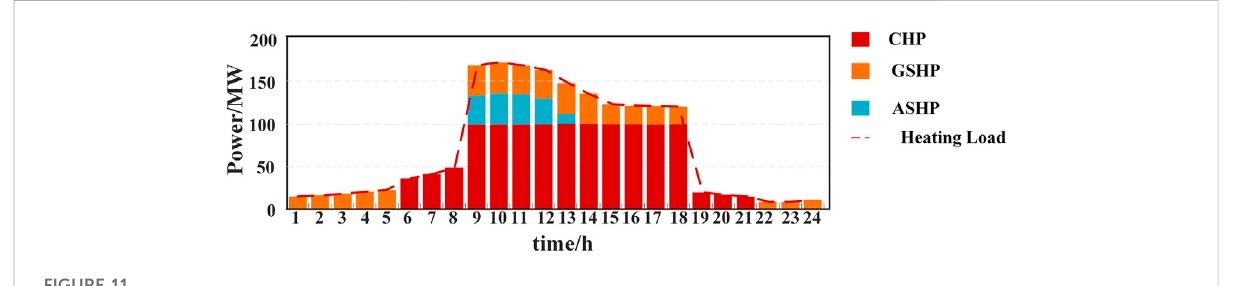
FIGURE 11 The optimal heat operation strategies in winter.